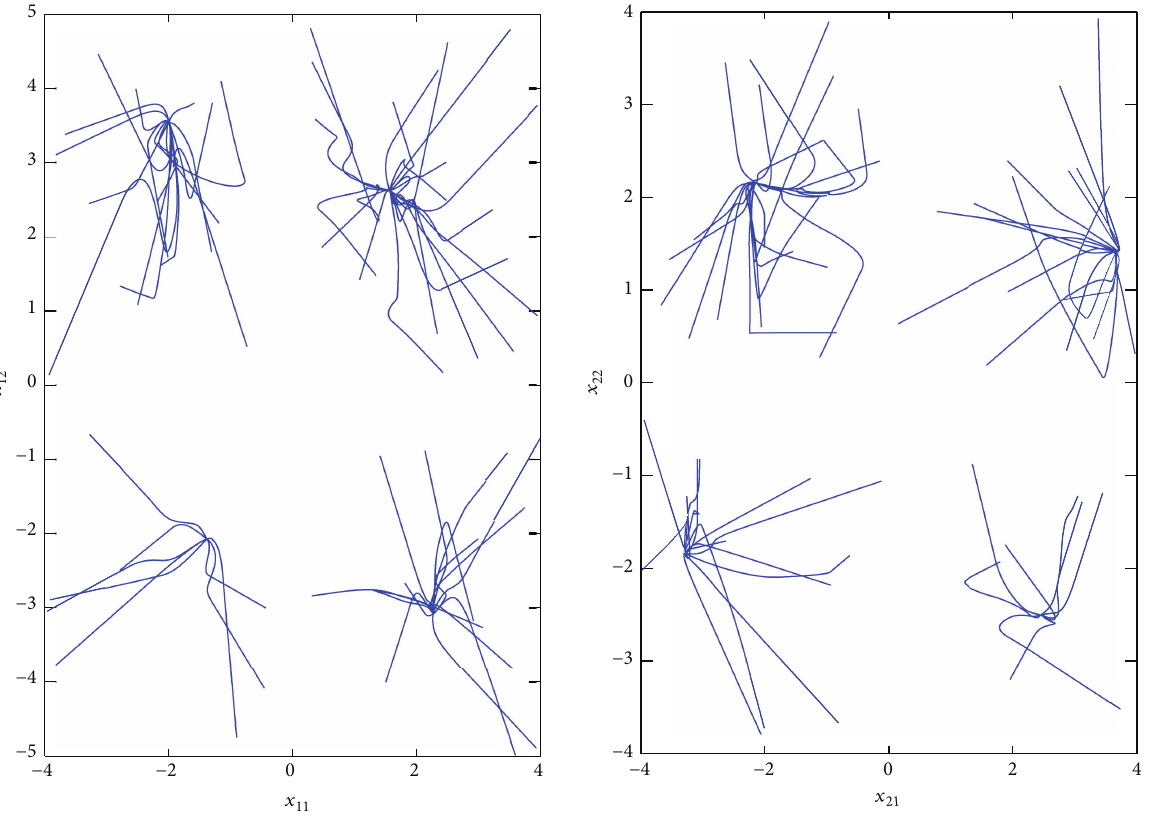
Figure 3: The phase of the MAM neural network